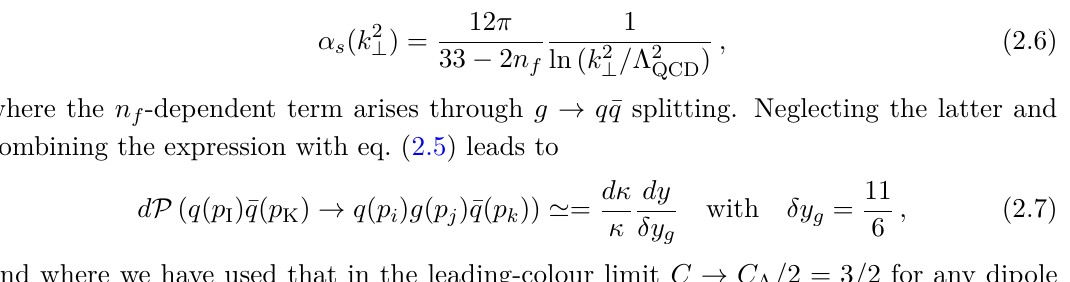
Figure 1. The phase space of effective gluon emission is discrete, since 1 gluons within a rapidity region δy g act coherently due to running-coupling effects. The κ (or equivalently the k 2 is also quantised, since 2 additional phase space folds opening due to gluon emission are quantised in units of δy g . See main text for more